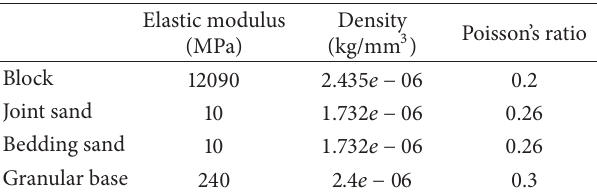
Table 1: Properties of materials used for the structural analysis.